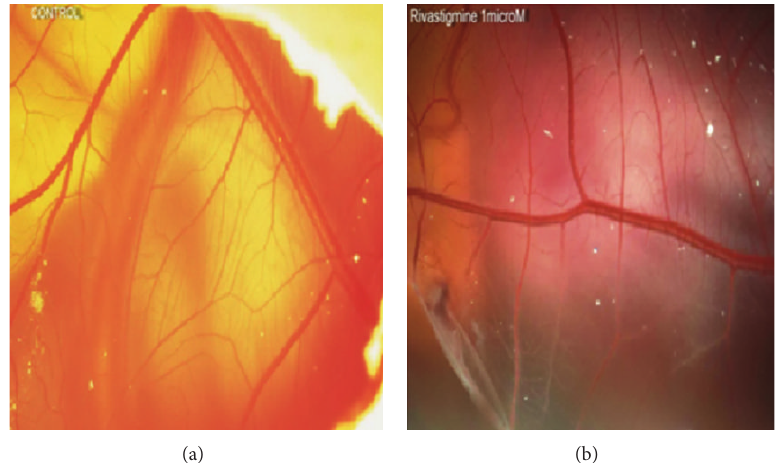
Figure 4: Effects of AChE inhibitors on angiogenesis in chicken chorioallantoic membrane model. Representative photographs of chorioallantoic membrane are shown for control (a) and rivastigmine (b) treated